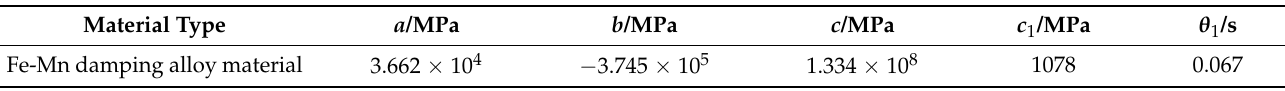
Table 4. Constitutive equation values of damping alloy unloading